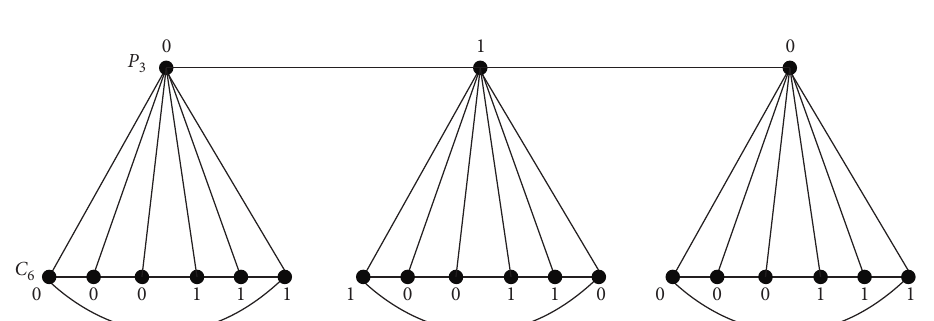
Figure 26: Logical labeling of P